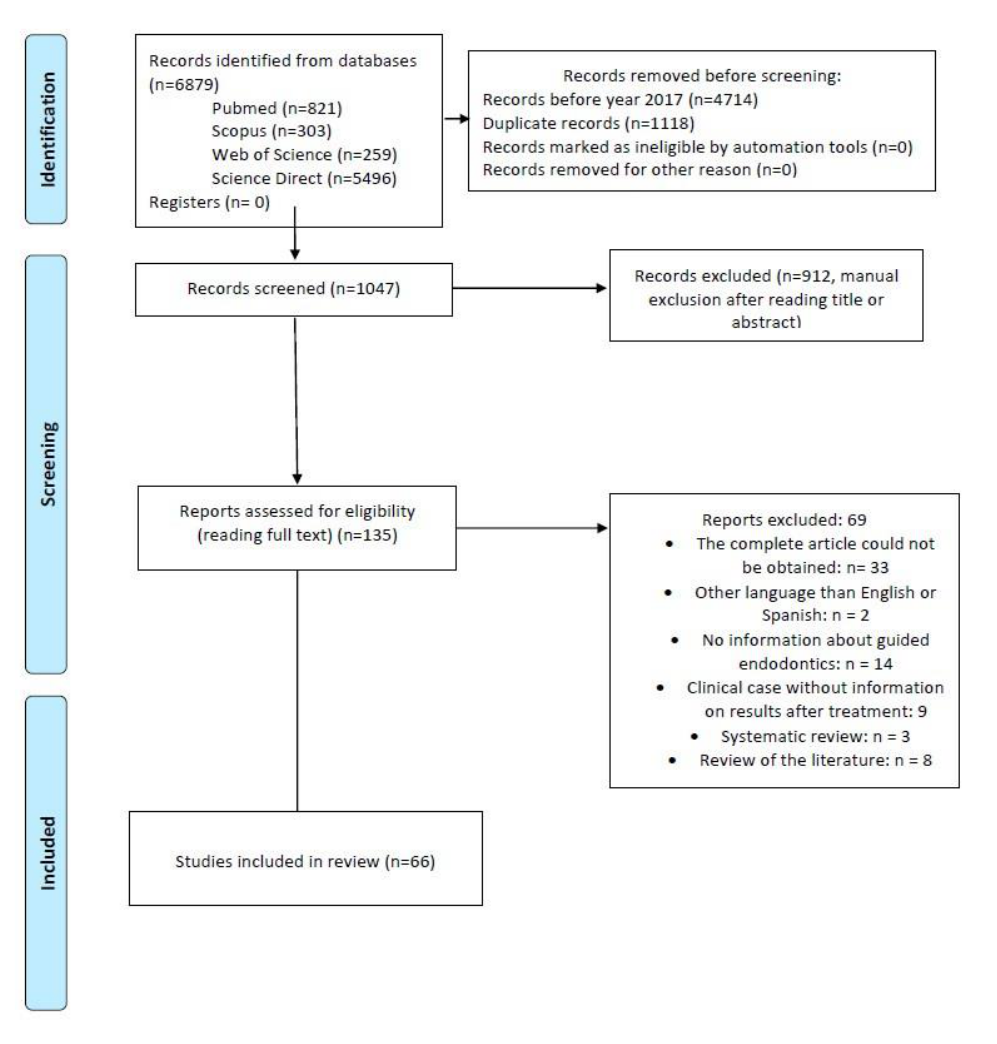
Figure 1. Study selection flowchart .